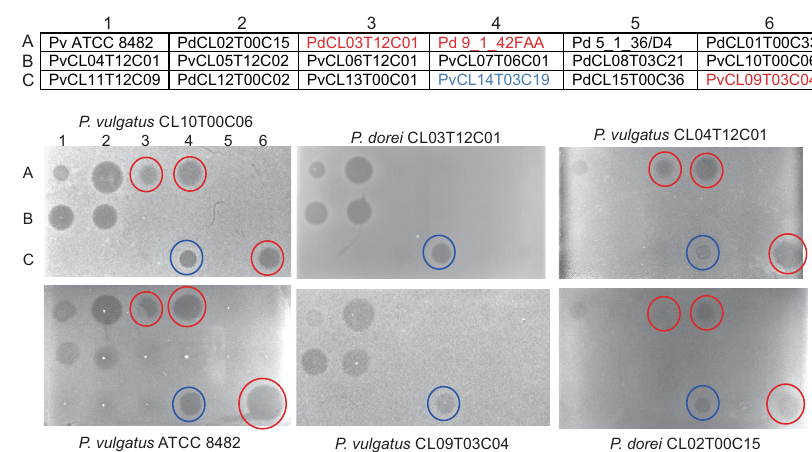
Fig. 1 Agar spot overlay assays of P. vulgatus and P. dorei strains. Upper panel: pattern of the 18 strains (three down, six across) that were spotted onto the plate and grown overnight to test for production of growth inhibitory factor(s) of the overlaid strains. Strains listed in red font produce BSAP-3, the strain listed in blue font produces bacteriodetocin A. Lower panel: The strain names on the top or bottom of the plates indicate the strain that was used as the overlay strain to test for growth inhibition by product(s) secreted by the strains listed above. All overlay assays were performed a minimum of four times with similar results. Source data are provided as a Source Data fi